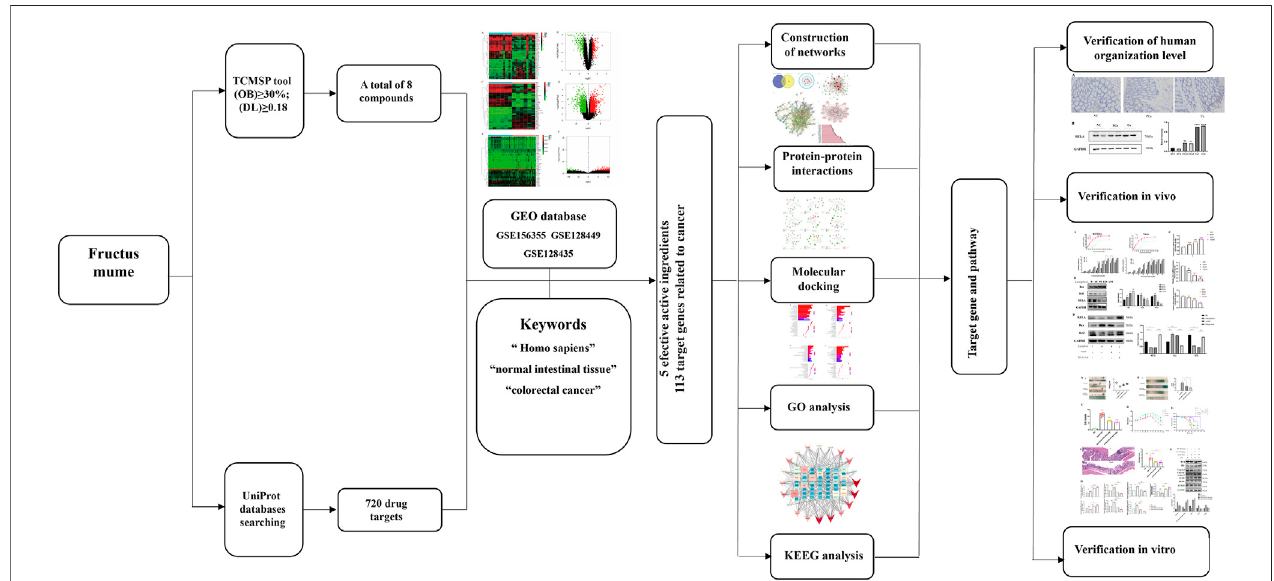
FIGURE 1 | Network pharmacological, molecular docking, and experience veri fi cation work fl ow for identifying PM targets in the treatment of colorectal cancer.